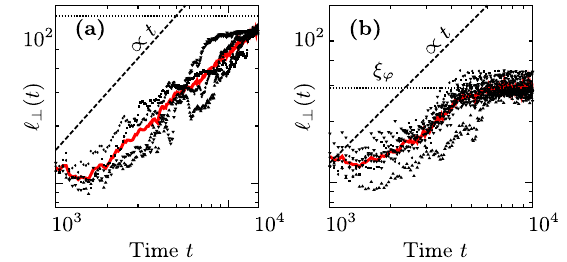
FIG. 8. Scaling of the coarsening dynamics inside the DSP regime at intermediate and long times. (a) Temporal evolution of l ⊥ ð t Þ for a set of four different seeds (data points) of wave patterns. The length scale l ⊥ ð t Þ roughly grows linearly with time and saturates at ξ φ ≡ l ⊥ ð t → ∞ Þ ¼ L . (b) Temporal evolution of l ⊥ ð t Þ for a set of six different seeds (data points) of cluster-lane patterns. The length scale l ⊥ ð t Þ roughly grows linearly with time and saturates at ξ φ ≡ l ⊥ ð t → ∞ Þ ≈ 0 . 4 L . The solid red lines in (a) and (b) represent the averaged time evolution of l ⊥